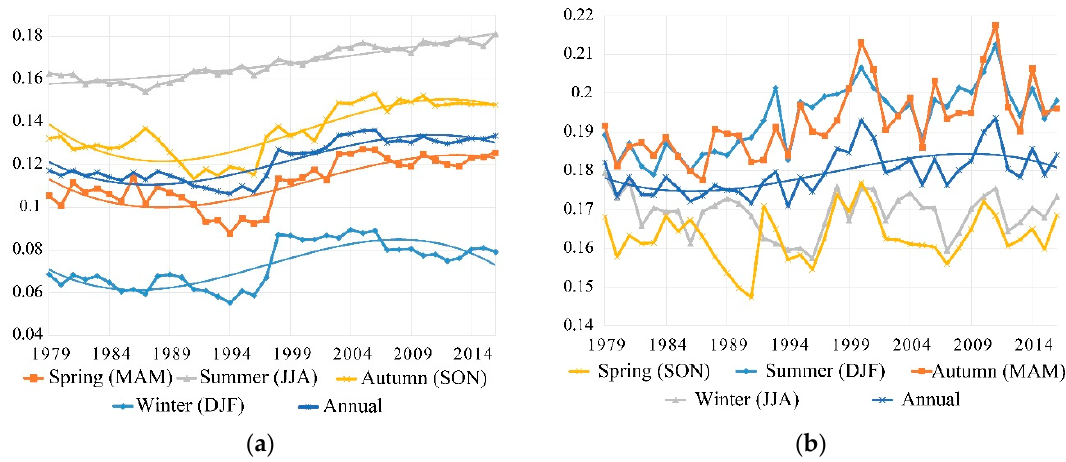
Figure 4. Annual and seasonal mean SM in the northern hemisphere ( a ) and in the southern hemisphere ( b ) and their trends between 1979 and 2016.